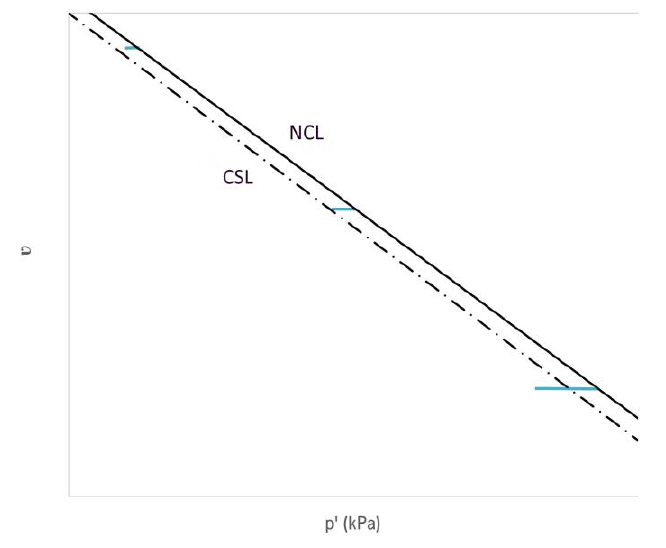
Figure 11. Detail of the stress trajectory and definition of the CSL.